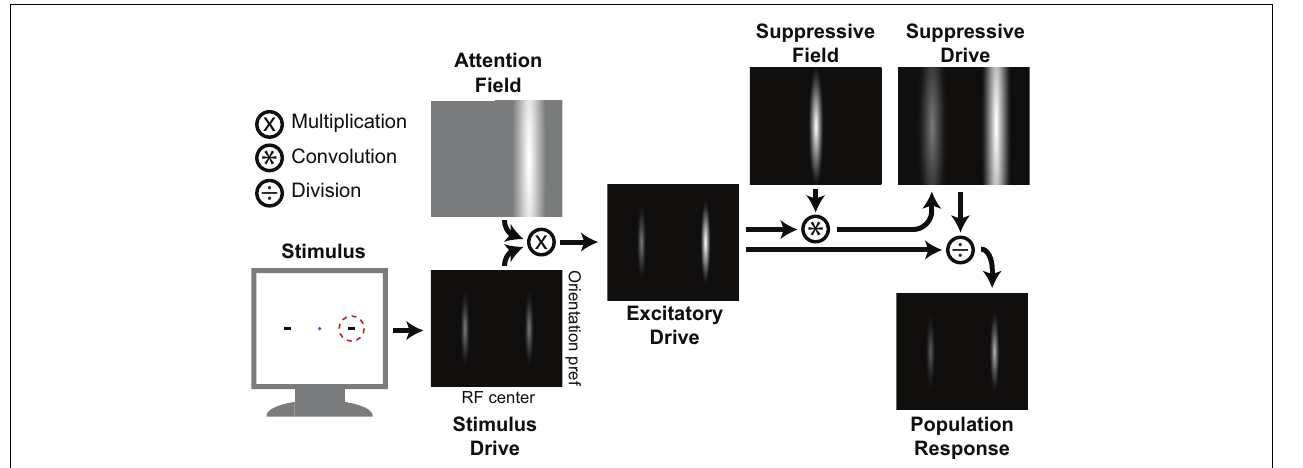
creates an Attention Field that is selective for the RF center dimension, but not for the orientation preference dimension. Multiplying the Attention Field point-by-point with the Stimulus Drive yields an Excitatory Drive, which is then convolved with a Suppressive Field (a Gaussian representing the lateral inhibition) to produce the Suppressive Drive, or surround-inhibition. Finally, dividing the Excitatory Drive by the Suppressive Drive yields a normalized Population Response, with the attended stimulus having a larger output than the unattended stimulus. Figure adapted from Reynolds and Heeger